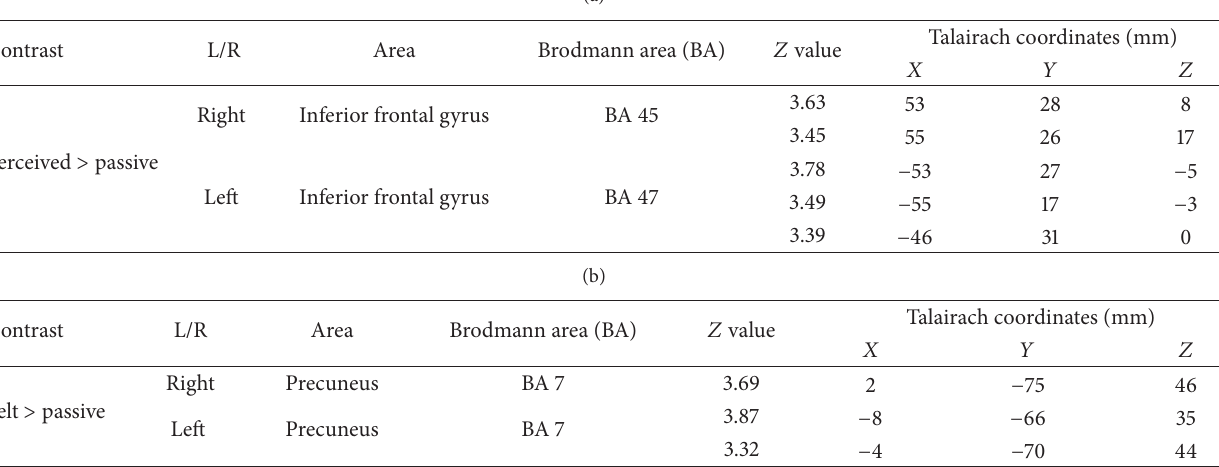
Table 1: Cortical areas where the blood-oxygen-level dependent signals increased with perceived emotion > passive listening (a) and felt emotion > passive listening (b); cluster threshold 𝑝 < 0.05 (corrected).